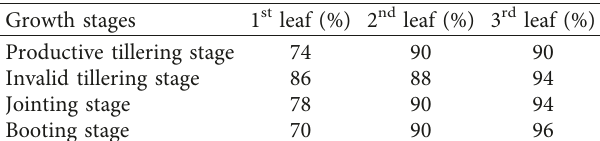
Table 5: Training accuracy of potassium status at different growth stages.